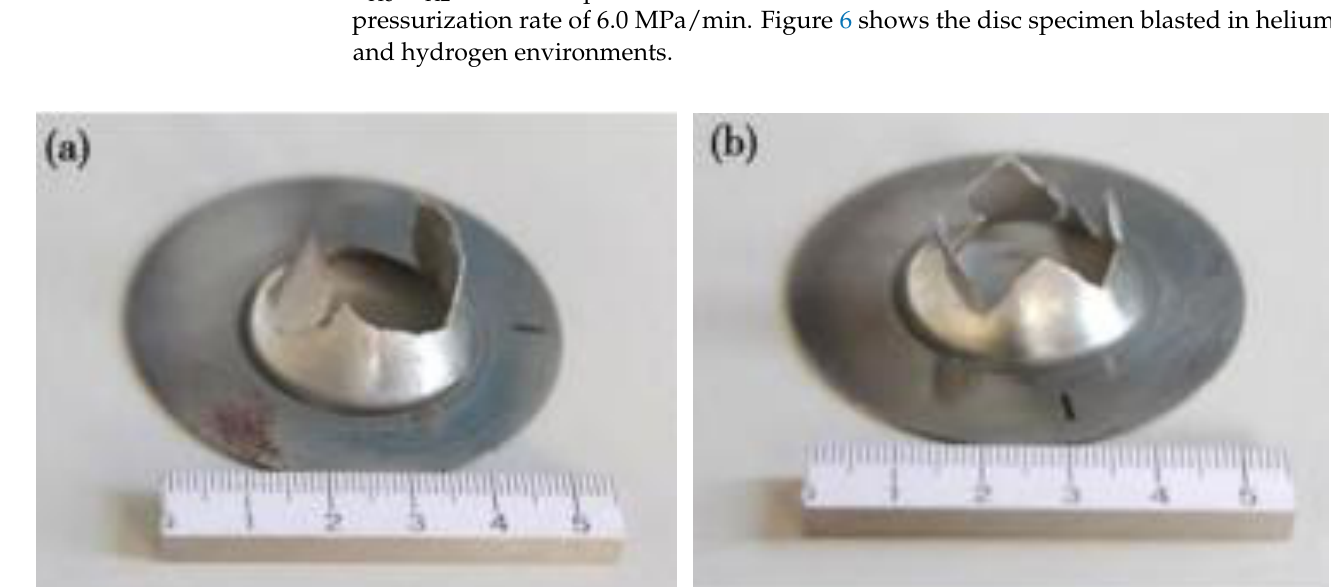
Table 7. The outcome of the tensile test.